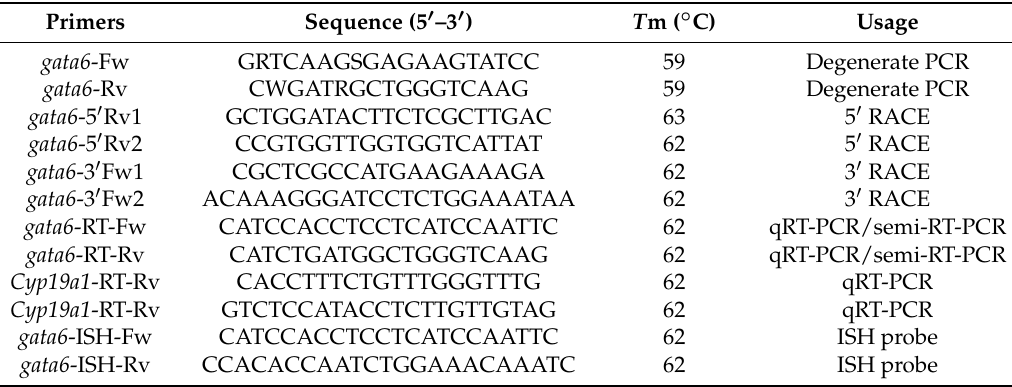
Table 1. Primers used in this study. RACE, rapid amplification of cDNA